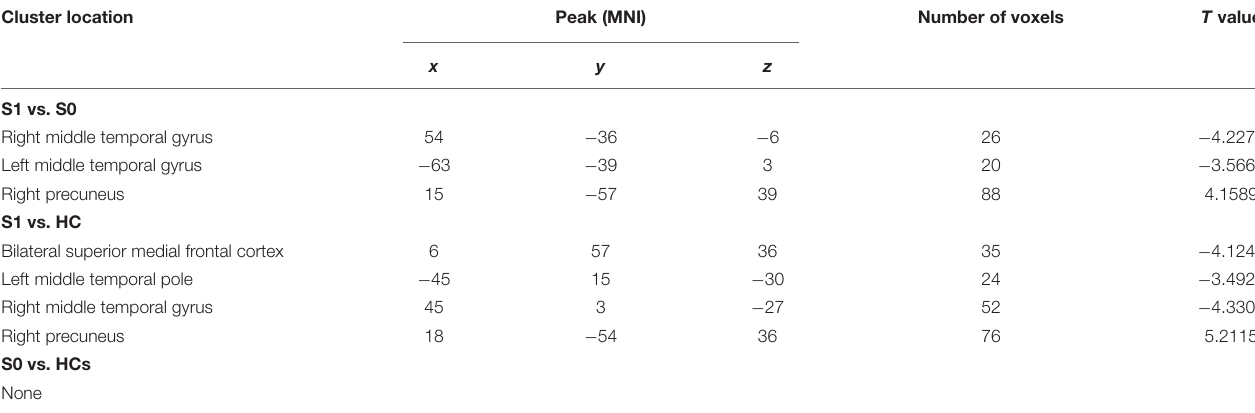
TABLE 2 | Significant NH differences of DMN across groups.